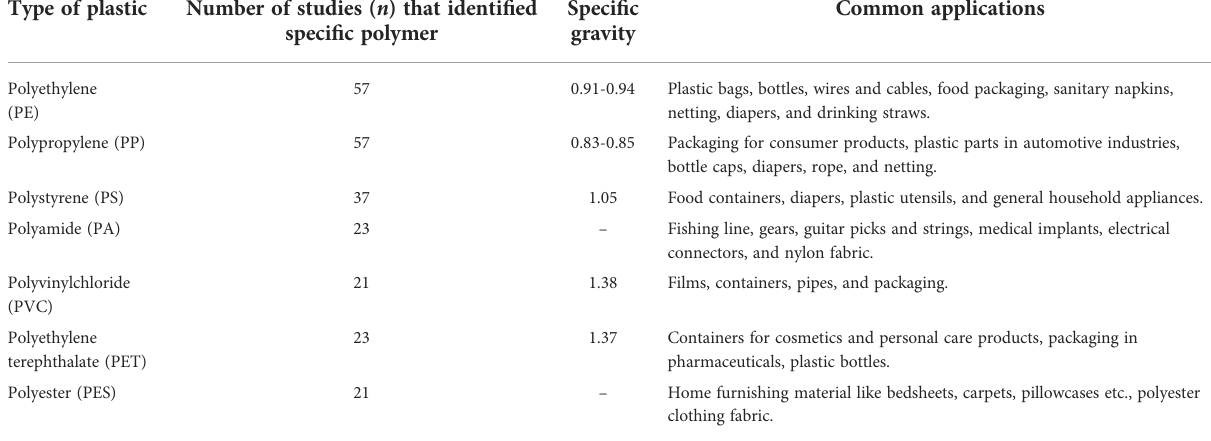
TABLE 4 Frequency of type of plastic as observed in the sediments, water, and biota samples across the globe and their common application (61 out of 74 studies reported the polymer type). Type of